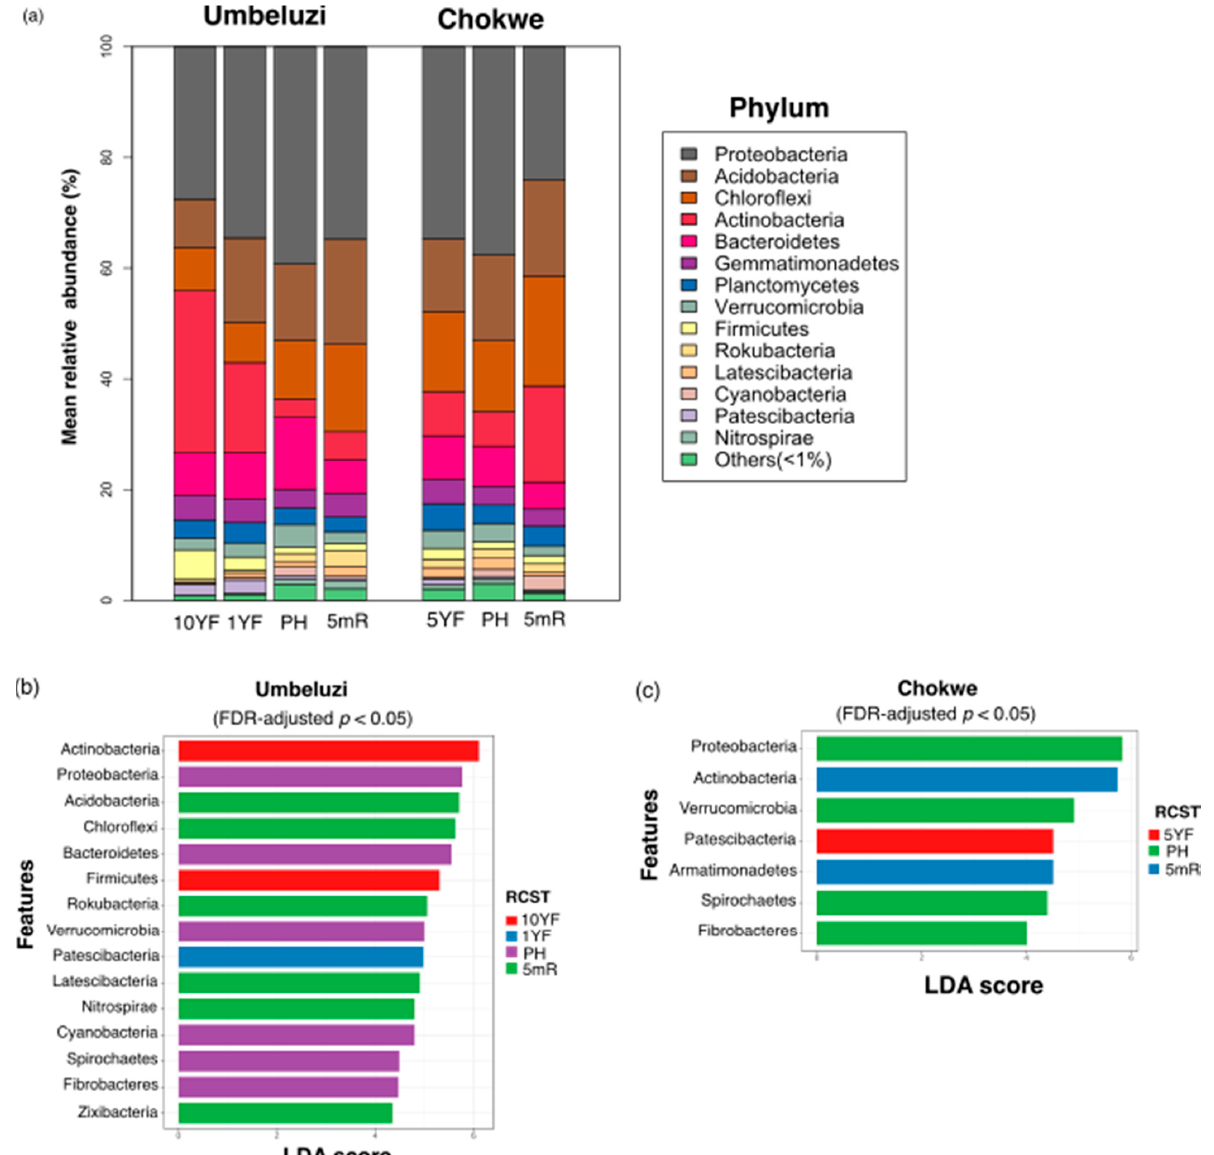
Figure 4. Dominant and differentially abundant (false discovery rate (FDR)-adjusted p < 0.05, least discriminant analysis (LDA) > 4.0) phylotypes at phylum taxonomic rank. ( a ) Mean relative abundance ( b ) differentially abundant phyla in Umbeluzi and ( c ) Differentially abundant phyla in Chokwe. 10YF, ten years fallow; 5YF, five years fallow; 1YF, one-year fallow; PH, postharvest; 5mR, five months off-season time